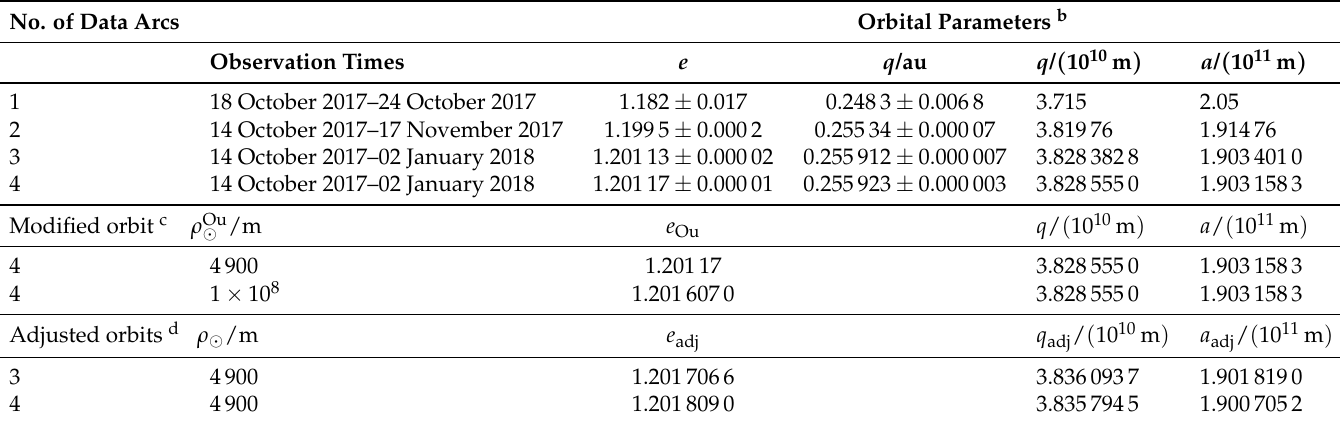
Table 1. Orbit characteristics during the ‘Oumuamua Sun flyby for four data arc evaluations a , modified orbit No. 4 and adjusted orbits No. 3 and